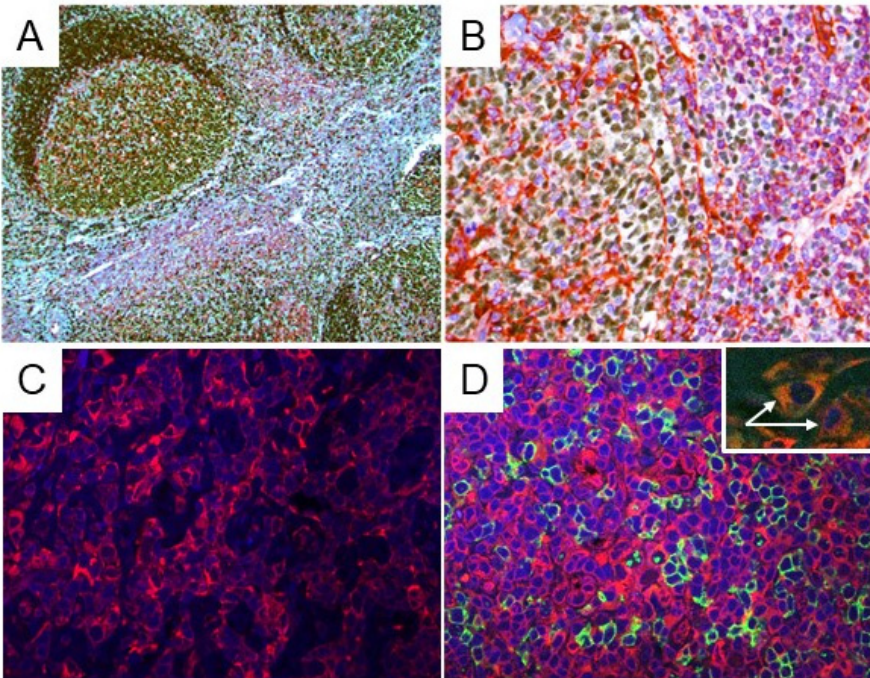
Figure 2. STING expression in reactive lymph nodes and tonsils. ( A , B ) Double immunostaining for STING (red) and PAX5 (dark brown) was performed in reactive lymph nodes and tonsils (free of malignancy). STING expression was observed in dendritic cells, histiocytes, and in a subset of reactive, small T-lymphocytes. The B-lymphocytes of the germinal centers were all STING-negative. Original magnification: ( A ) × 100; ( B ) × 400. ( C , D ) Indirect immunofluorescence for STING (red) and CD20 (green) was performed on reactive lymph nodes and tonsils: (left panel) STING expression is present in the T-cell area of the reactive lymph node (interfollicular area); (right panel) CD20+ B lymphocytes (green) are all negative for STING expression (red), which is restricted to T-lymphocytes. Two histiocytes (white arrows) positive for CD68 (green) and STING (red) are shown in the inset, as well.